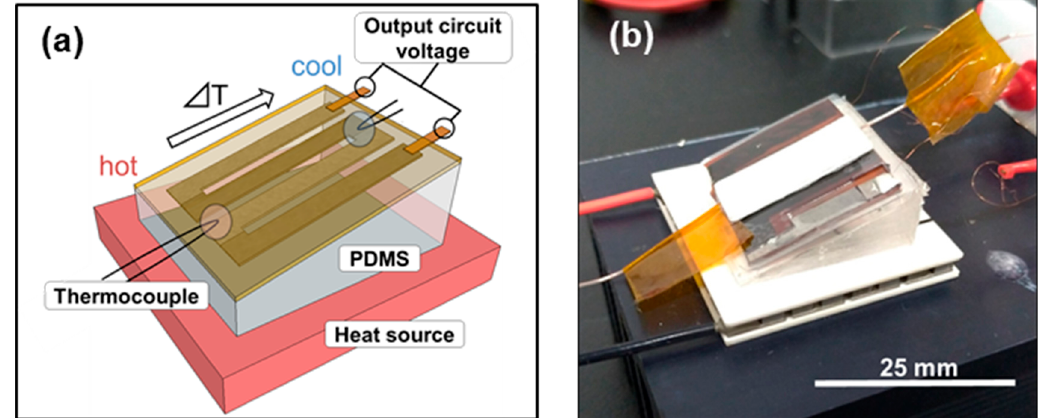
Figure 3. ( a ) Schematic diagram and ( b ) photograph of the V oc measurement method.